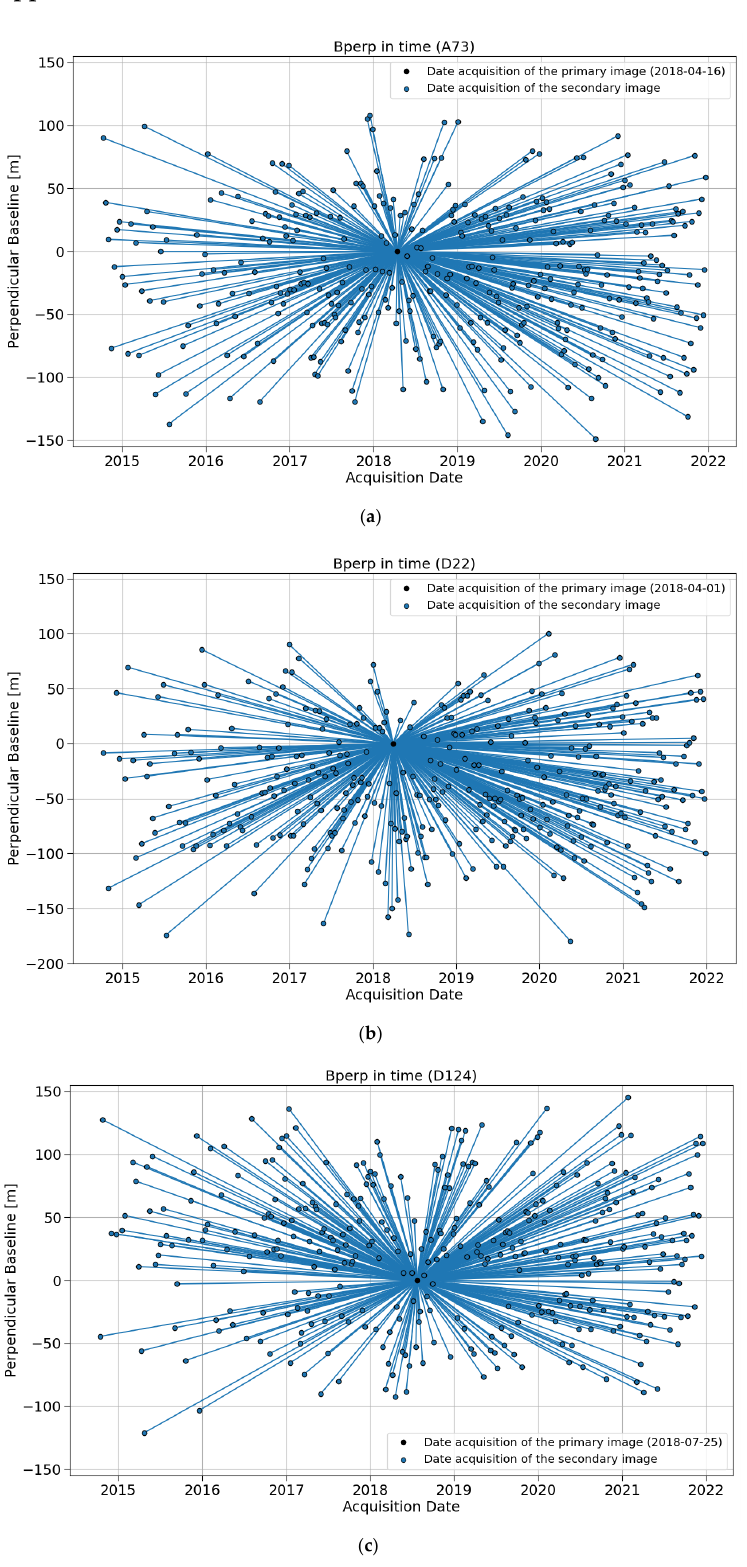
Figure A1. Star graphs showing the temporal/perpendicular baseline distribution between images for the track ( a ) A73, ( b ) D22, and ( c ) D124.